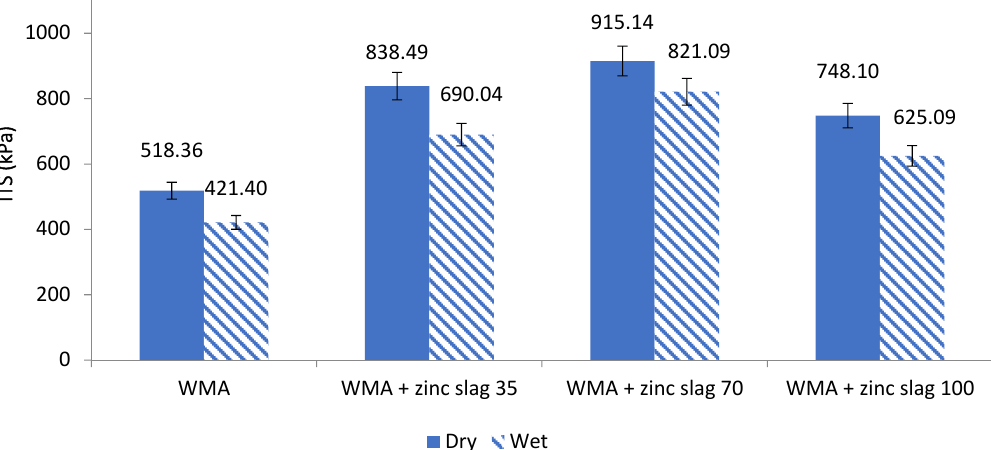
Figure 7. ITS diagram of the asphalt samples in dry and saturated states.